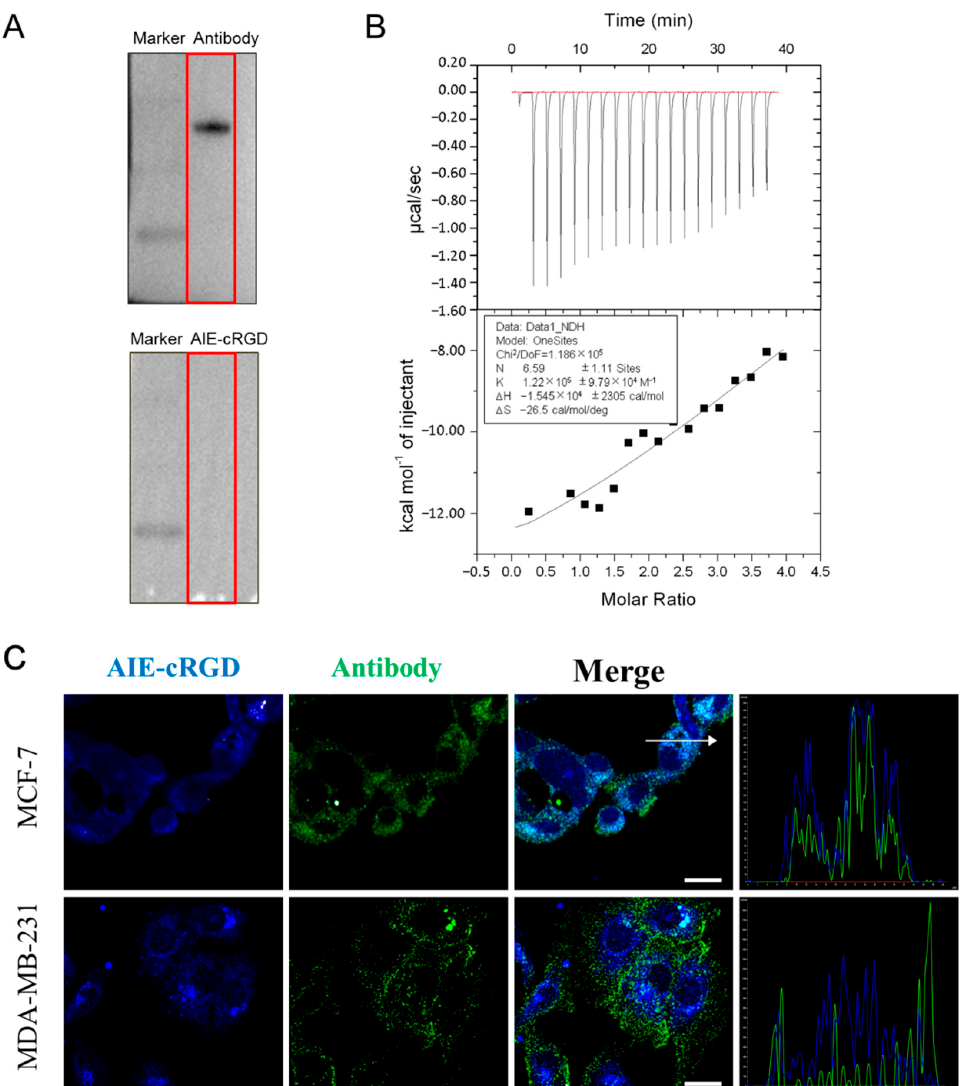
Figure 2. ( A ) Western blotting test for integrin α v β 3 proteins. ( B ) The ITC data for measurement of reaction rate of AIE-cRGD (100 μ M) with protein integrin α v β 3 (5 μ M). ( C ) Colocalization coefficients of AIE–cRGD and anti-integrin antibody in MCF-7, MDA-MB-231. Bar = 20 μ m. The cells were incubated with AIE–cRGD (100 μ g/mL), followed by further incubation with anti-integrin α v β 3 antibody overnight at 4 °C. The curve graph is a result of measuring the intensity of two kinds of fluorescence at random position of white arrows in the merge diagram of two cells.